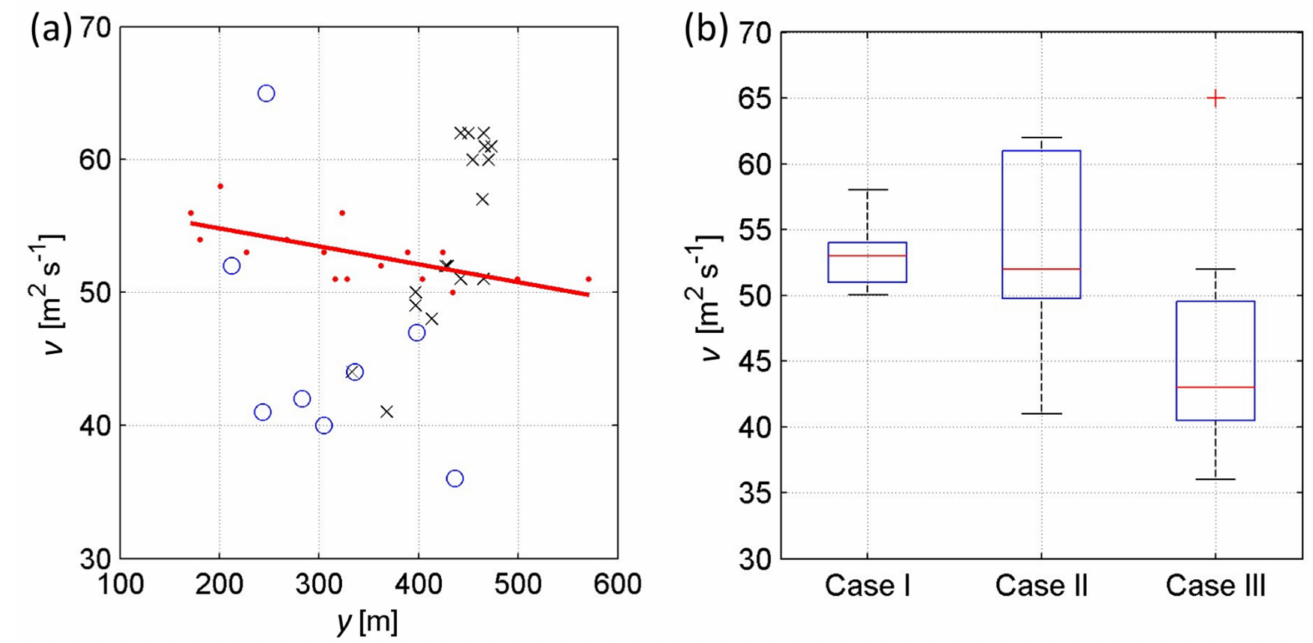
Figure 13. ( a ) Horizontal eddy viscosity coefficient ( ν ) versus the cross-shore location. Symbols indicate the observations for Case I (red), Case II (black), and Case III (blue). Only the regression of Case I had a p value smaller than 0.01, so fit lines are not shown for Cases II and III. ( b ) Boxplots of the horizontal eddy viscosity coefficients ( ν ) for Cases I, II, and